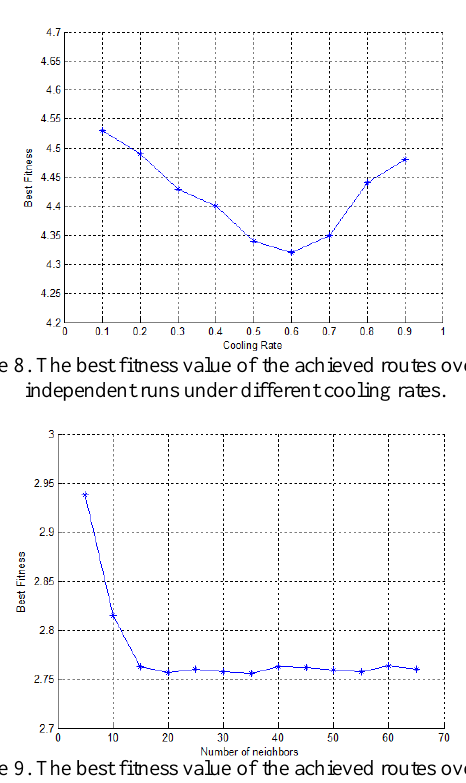
Figure 7. The best fitness value of the achieved routes over 100 independent runs under different population sizes